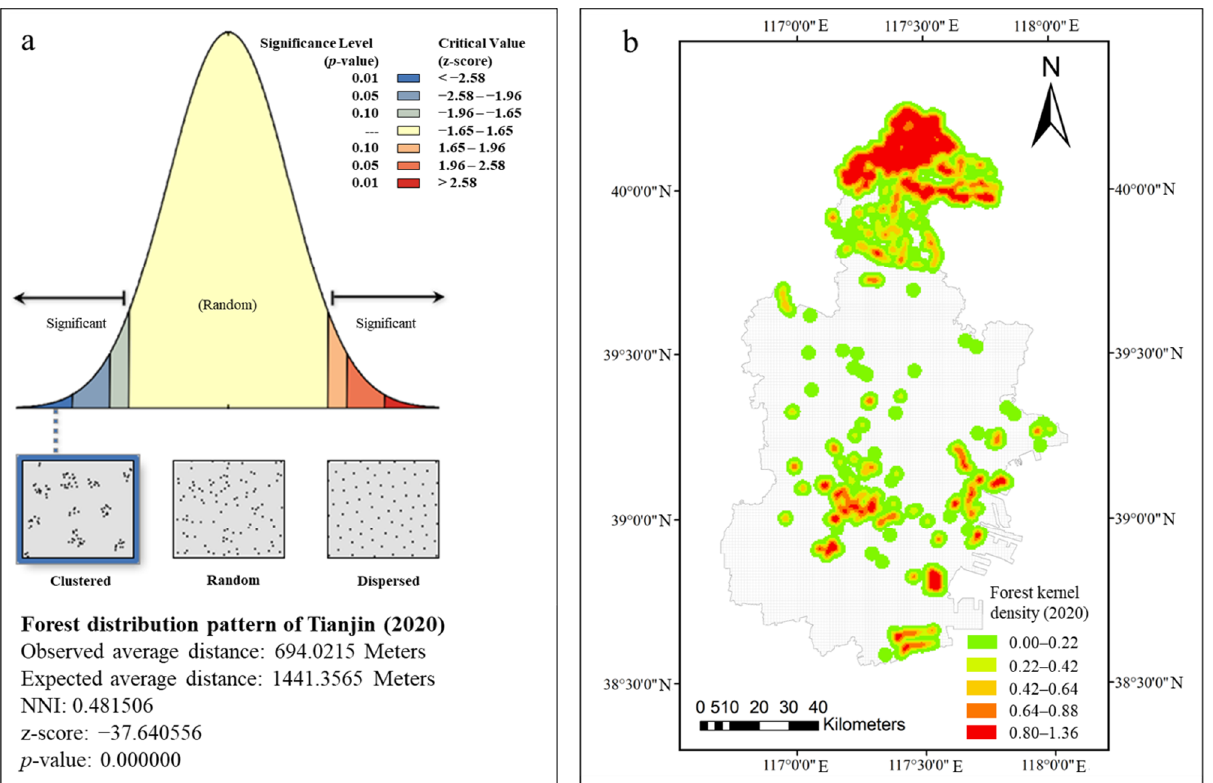
Figure 5. Forest distribution pattern of Tianjin (2020) ( a ), forest kernel density of Tianjin (2020) ( b ) .